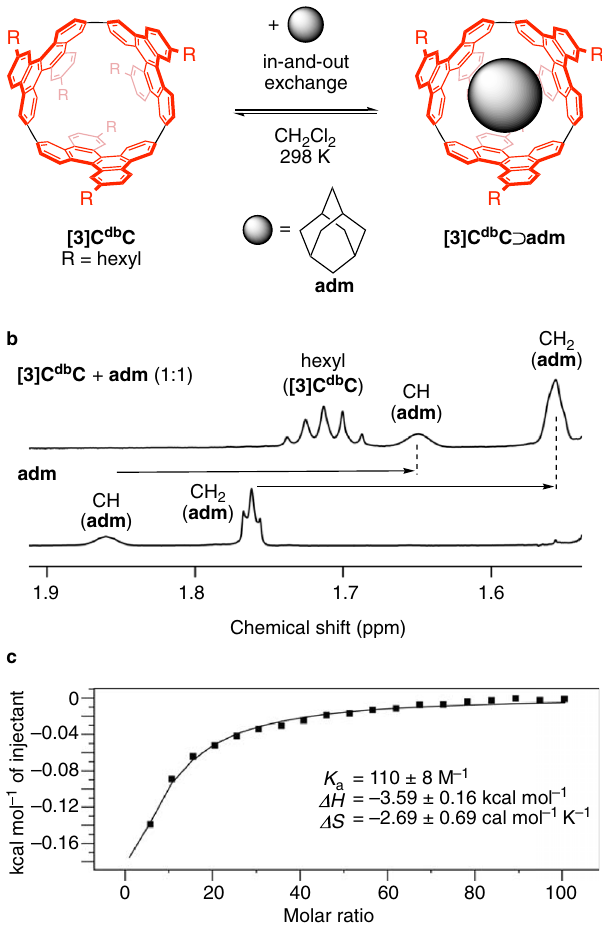
Fig. 2 Assembly of a hybrid nanocarbon peapod in a molecular